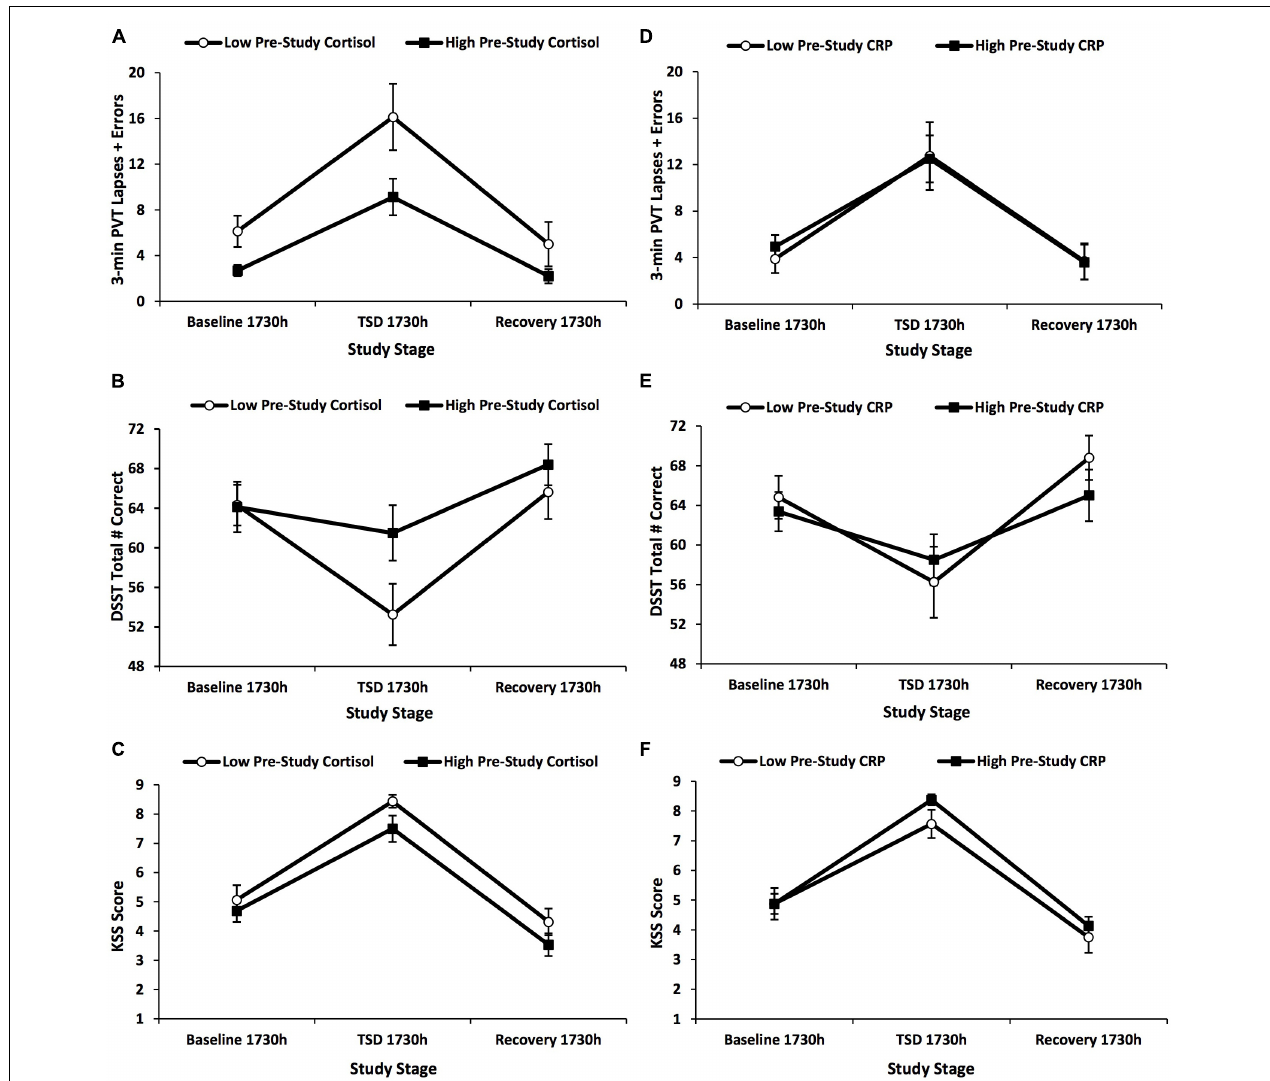
FIGURE 4 | Changes in 3-min Psychomotor Vigilance Test (PVT) lapses and errors, Digit Symbol Substitution Test (DSST) total number correct, and Karolinska Sleepiness Scale (KSS) scores across the 5-day experiment defined by a median split on pre-study cortisol and pre-study C-reactive protein (CRP) values. The graphs show the changes in (A,D) 3-min PVT lapses and errors; (B,E) DSST total number correct; and (C,F) KSS scores by a median split on (A–C) pre-study cortisol values and (D–F) pre-study CRP values. Three-minute PVT and DSST performance and KSS scores did not show any significant findings for these analyses. N = 15 in the recovery points of the high pre-study cortisol group in (A–F) due to one participant withdrawn from the study during recovery night 1; all other data points are N = 16. Data are mean ±